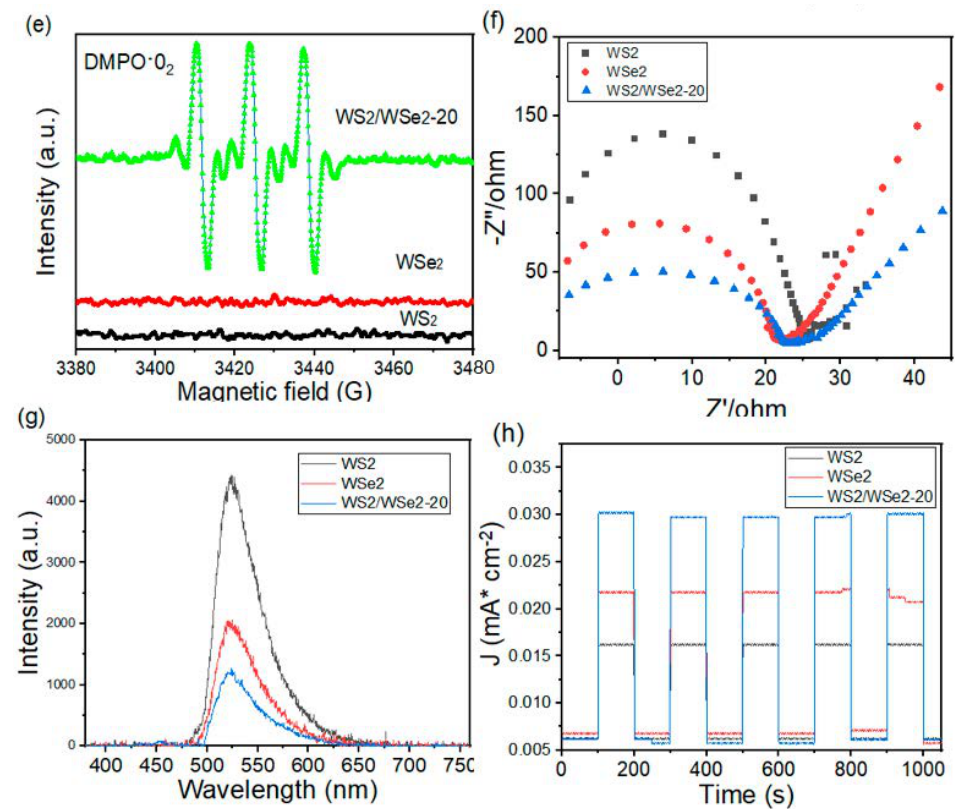
Figure 5. ( a ) CR spectra adsorption changes during the photocatalytic process, ( b ) Photodegradation curves of CR, ( c ) cycling test for WS 2 /WSe 2 -20 sample, ( d ) reactive species trapping tests, and ( e ) DMPO spin-trapping ESR spectra of DMPO-O 2 − . (three repeat tests to estimate error bars), ( f ) electrochemical impedance spectroscopy of the as-fabricated photocatalysts, ( g ) photoluminescence spectroscopy (PL), and ( h ) transient photocurrent curves of WS 2 , WSe 2 , and WS 2 /WSe 2 -20.